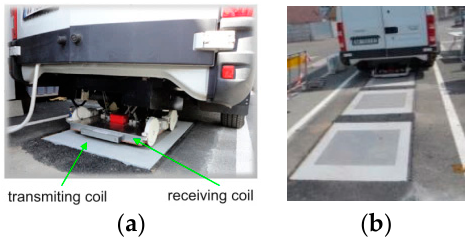
Figure 9. Real tests: ( a ) static and ( b ) dynamic charging of of electric vehicles ( EV ) .